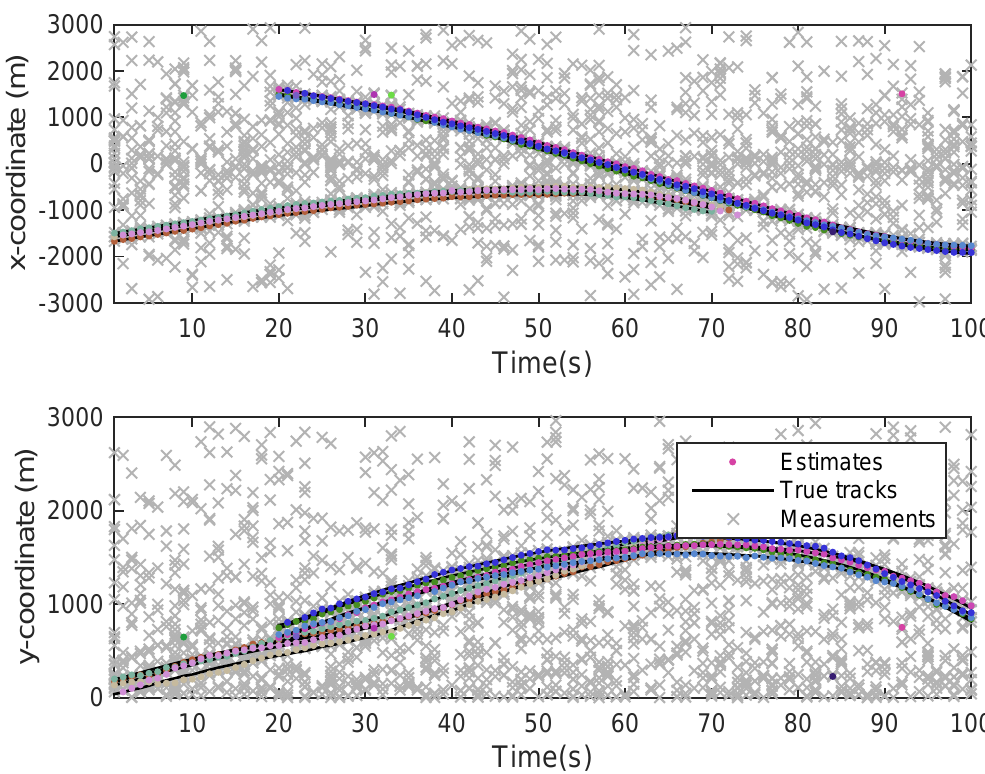
Figure 7. The state estimation by Gibbs GLMB filter.